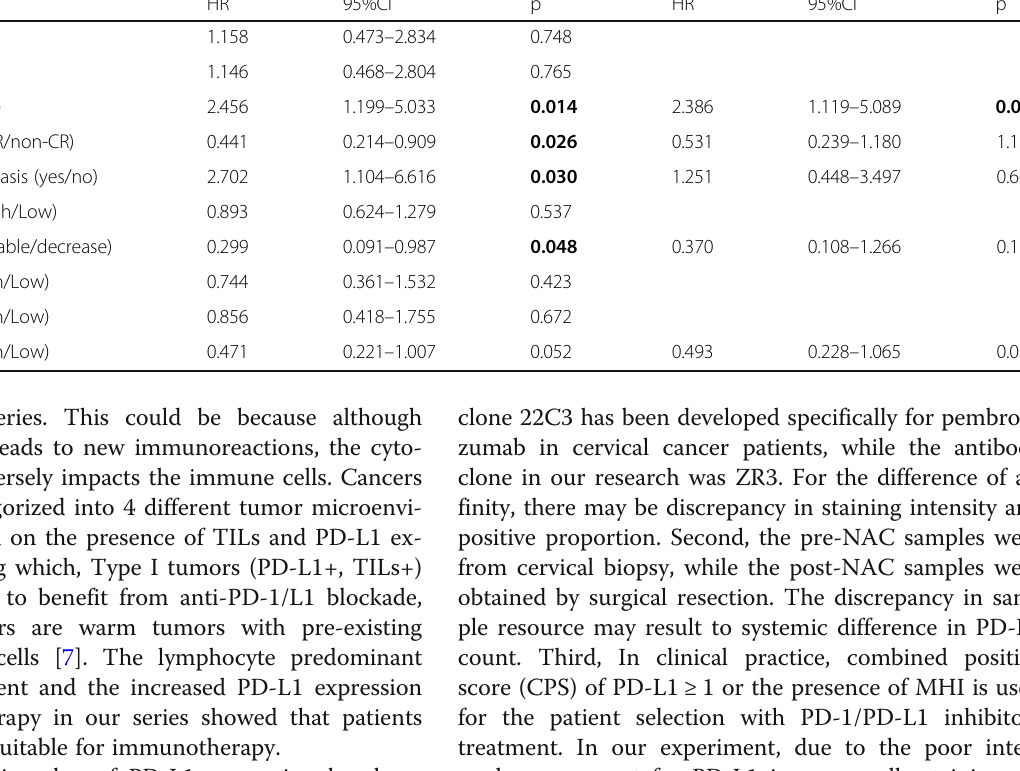
Table 2 Univaraite and multivariate analysis of DFS in cervical cancer patients DFS (univariate